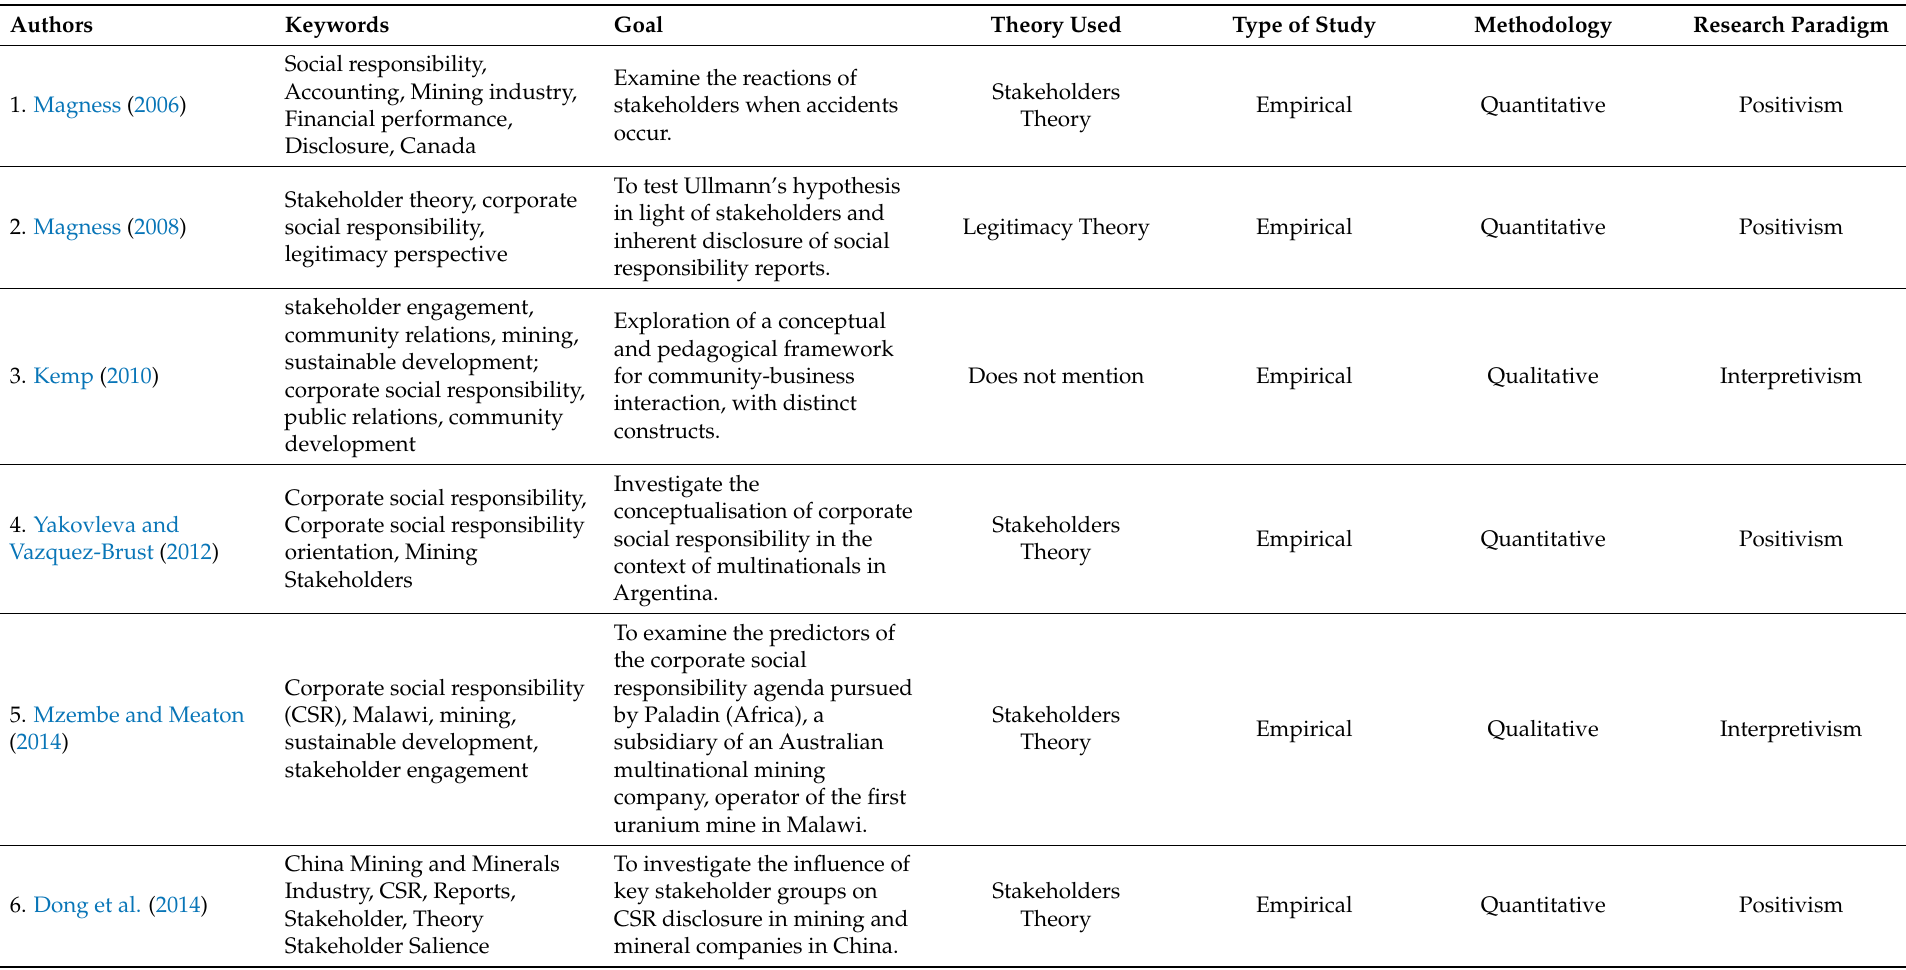
Table 3. Conceptual framework (n =